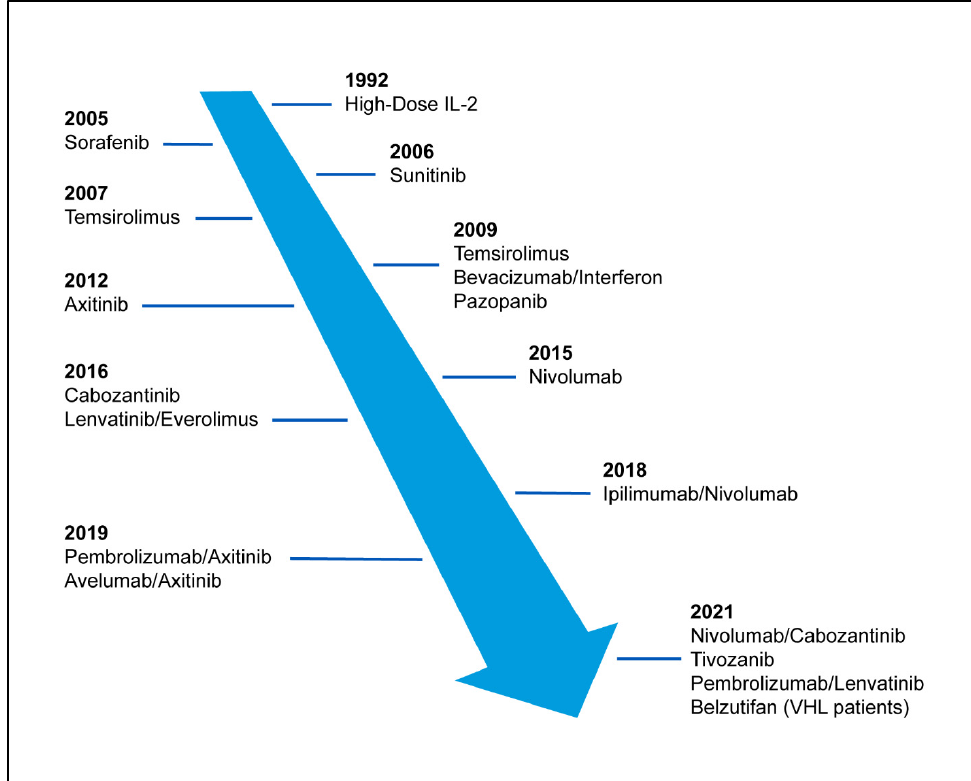
Figure 1. Timeline of FDA approved agents and combination treatments for metastatic renal cell carcinoma.